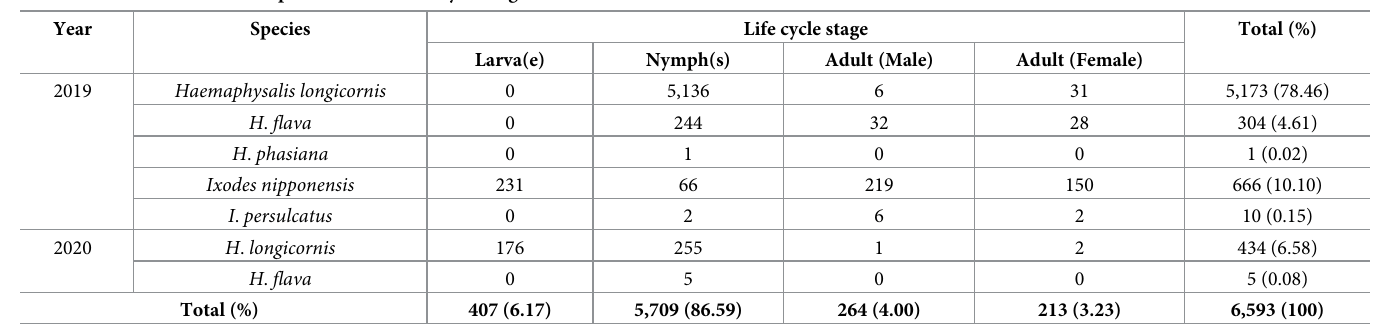
Table 2. Total number of tick species based on life cycle